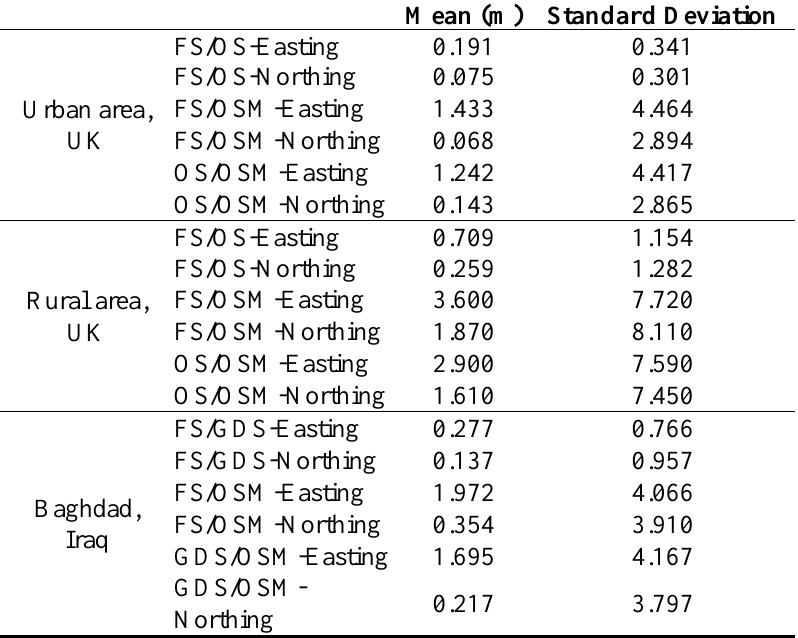
Table 2. Summary of positional discrepancies statistics of compared datasets.